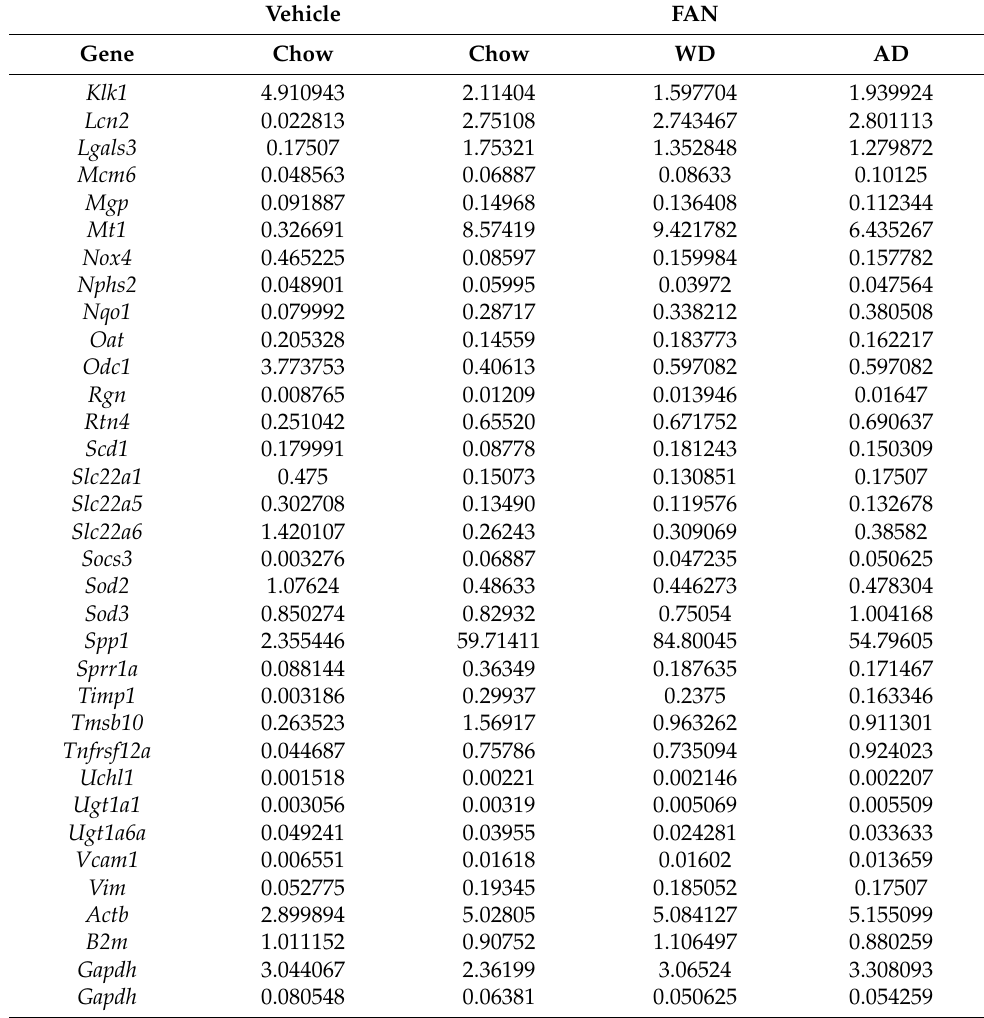
Table A4. RT-PCR data from diet-FAN study.